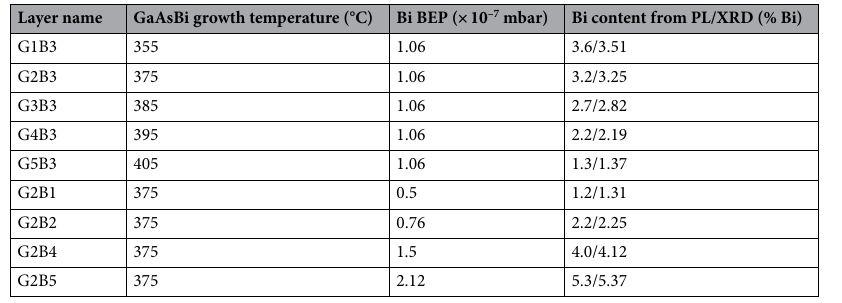
Table 1. Growth details for the GaAsBi devices 25